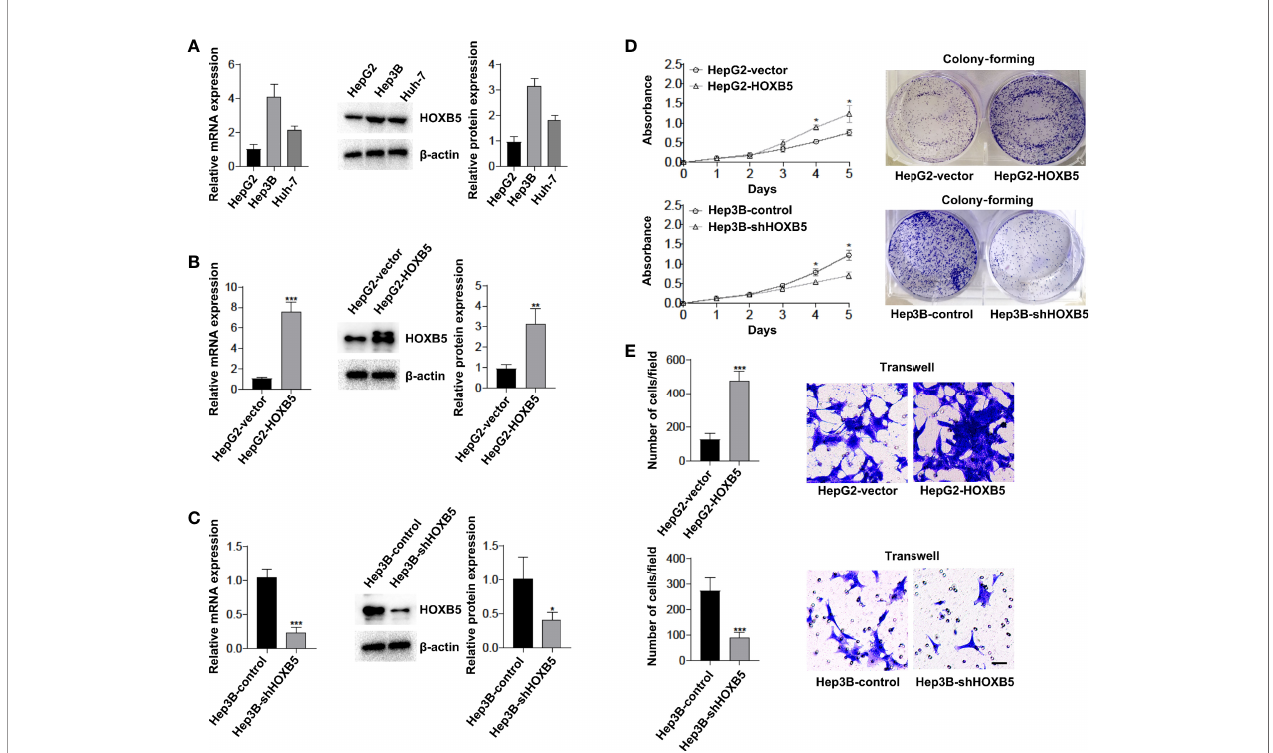
FIGURE 2 | HOXB5 promotes cell proliferation and migration of HCC cells. (A) Expression of HOXB5 in HepG2, Huh-7 and Hep3B HCC cell lines as tested by qRT- PCR and Western bolt. Data are mean ± SD. **p < 0.01, ***p < 0.001; (B, C) Expression of HOXB5 in HepG2-HOXB5 and Hep3B-shHOXB5, and their corresponding control cell lines as tested by qRT-PCR and Western bolt. Data are mean ± SD. **p < 0.01, ***p < 0.001; (D) CCK8 and clonogenicity assays of proliferation capability of HCC cells. Data are mean ± SD. *p < 0.05, ***p < 0.001; (E) Invasion and migration assays of HepG2-HOXB5 and Hep3B-shHOXB5, and their corresponding control cell lines as tested by transwell experiment. Data are mean ± SD. *p <0.05. Scale bars,